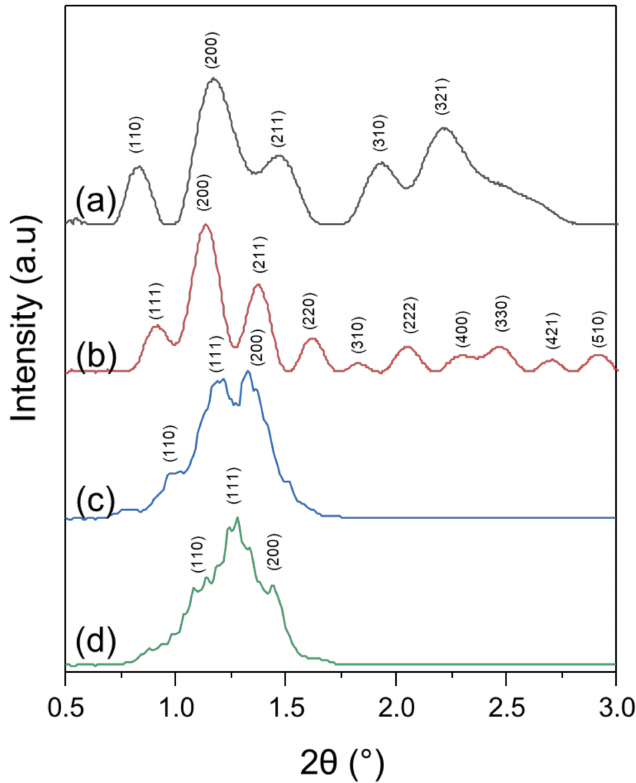
Figure 6. XRD patterns with marked peaks of fitted space groups of ( a ) GMO:PEO- b -PLA 4:1, ( b ) GMO:PEO- b -PLA 9:1, ( c ) GMO:PEO- b -PMEC 4:1, ( d ) GMO:PEO- b -PMEC